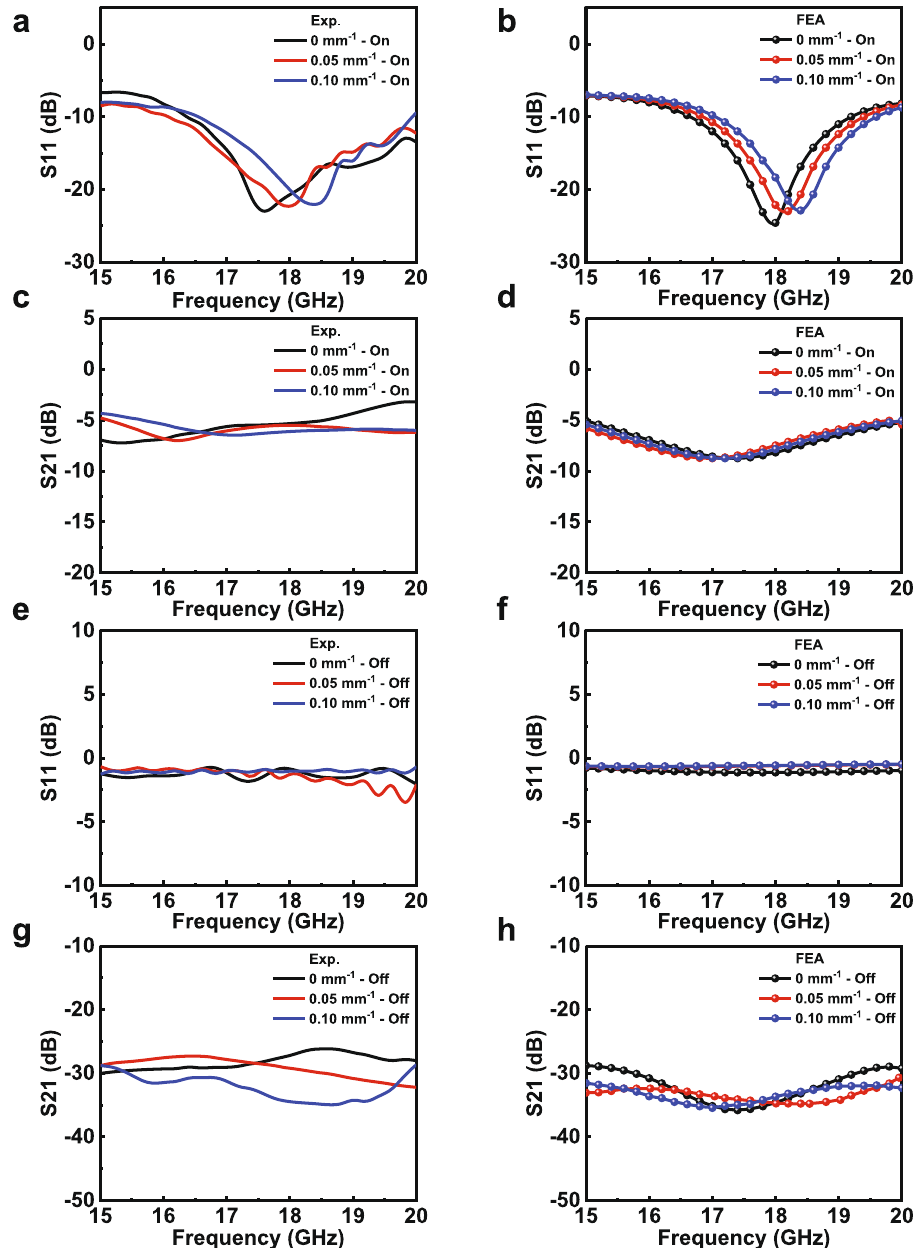
Fig. 6 RF characteristics under different bending curvatures. On state S 11 of ( a ) experiment and ( b ) simulation; On state S 21 of ( c ) experiment and ( d ) simulation; Off state S 11 of ( e ) experiment and ( f ) simulation; Off state S 21 of ( g ) experiment and ( h ) simulation under different bending curvatures radius of the fl exible